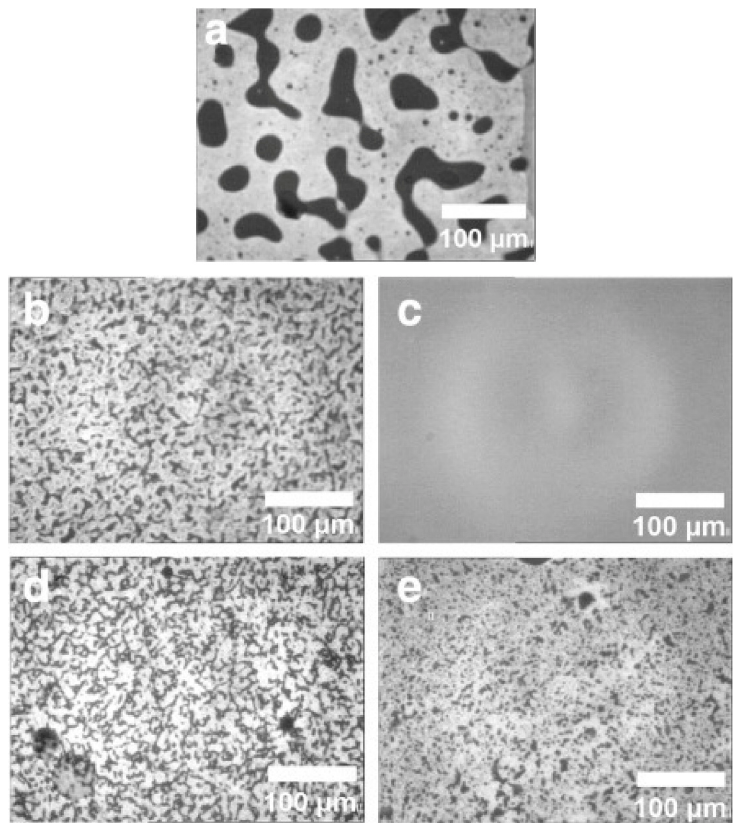
Figure 14. Fluorescence images of ( a ) BA/EVA, ( b ) BA/EVA/20A PM, ( c ) BA/EVA/20A MB, ( d ) BA/EVA/43B (PM), and ( e ) BA/EVA/43B (MB) (reprinted from Figure 1 of [217] with the permission of Elsevier).